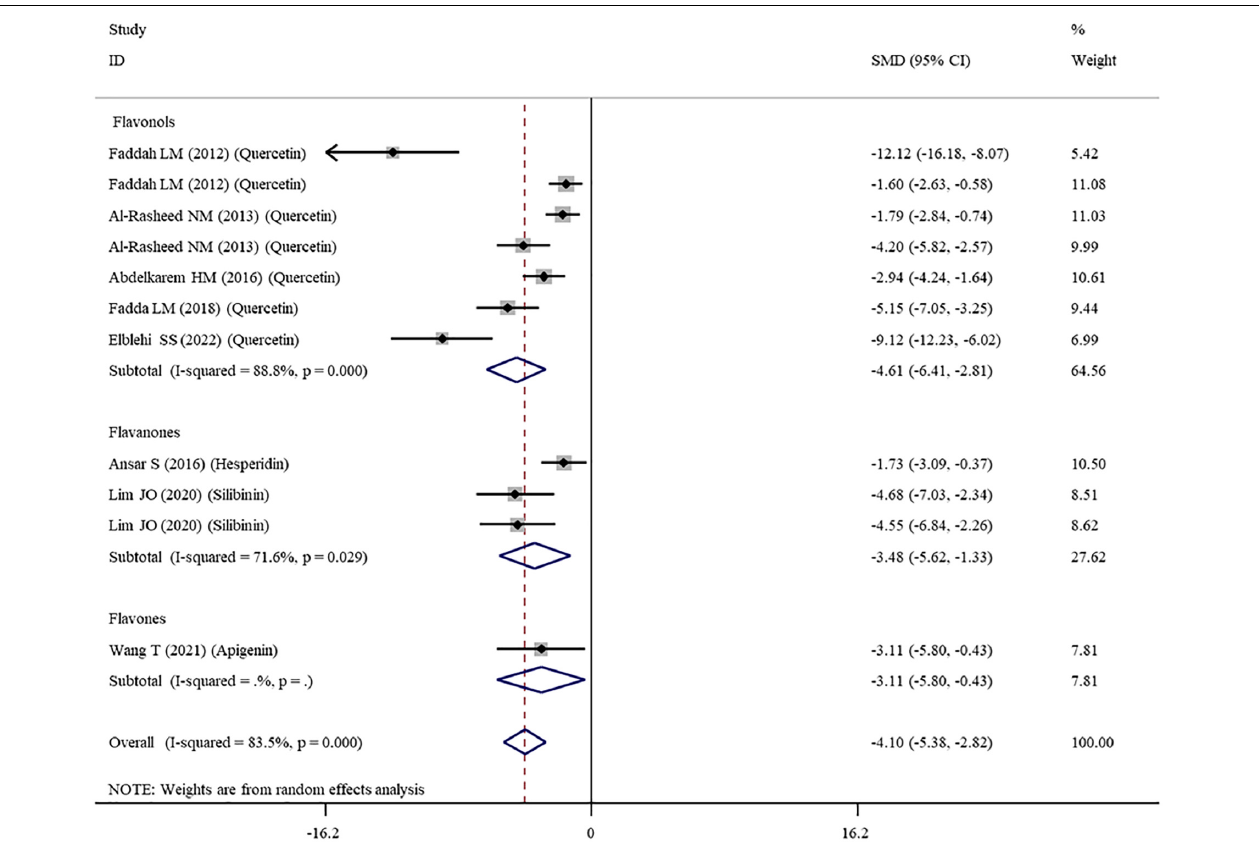
FIGURE 7 | Forest plots to show the effects of flavonoid supplementation on IL-6 levels compared with the nanomaterial exposure group. IL, interleukin; SMD, standardized mean difference; CI, confidence